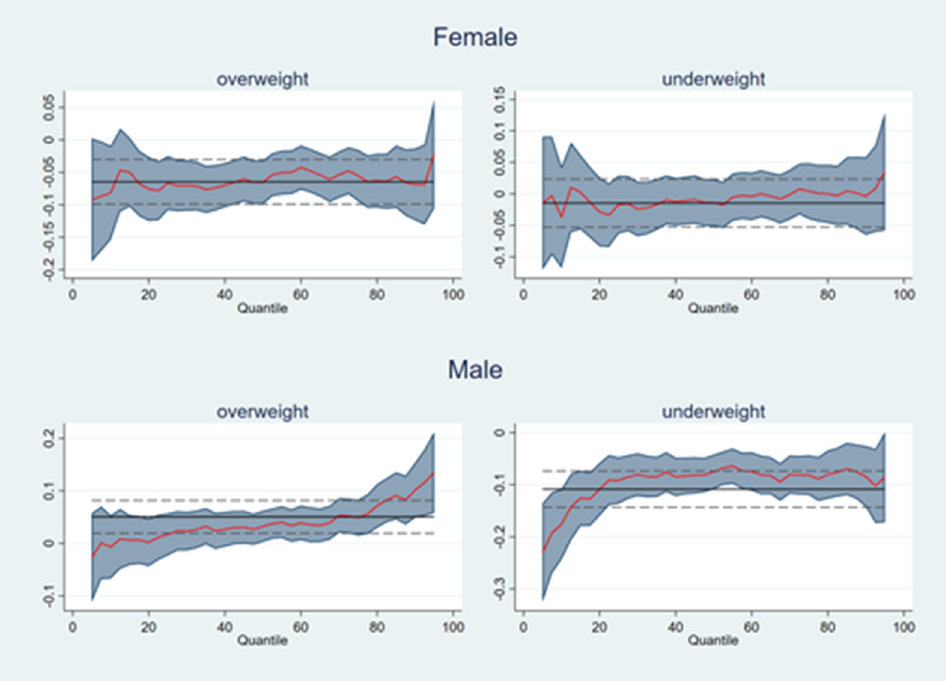
Figure 3. Results of quantile regression. Note: Demographics, socioeconomic status, regional controls, and fixed effects variables were all added in each regression, which had robust standard errors.